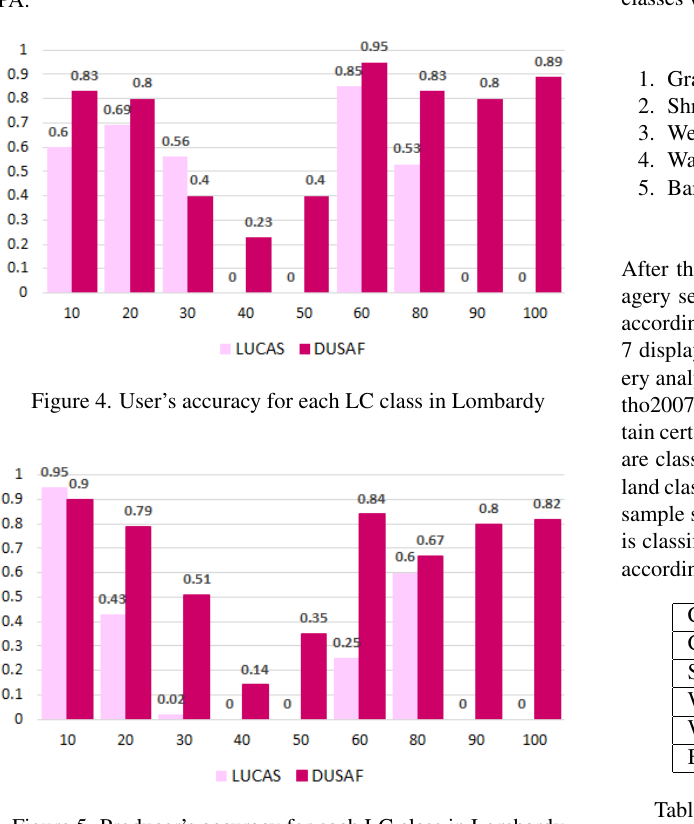
Furthermore, the Figure 4 and 5 depict differences in UA and PA, used. Numbers on the horizontal axis denote the classes of GL30